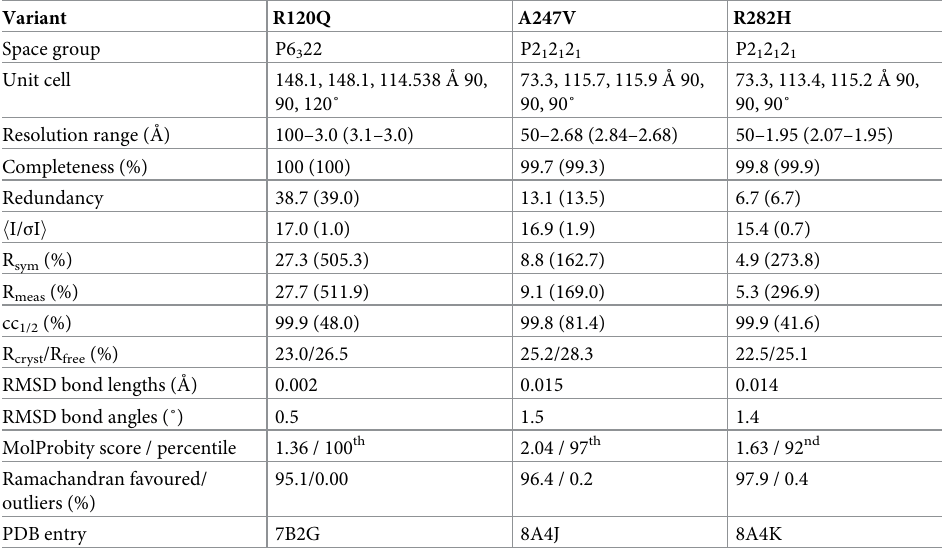
Table 1. Data processing and refinement statistics. Data in parentheses refer to the highest-resolution